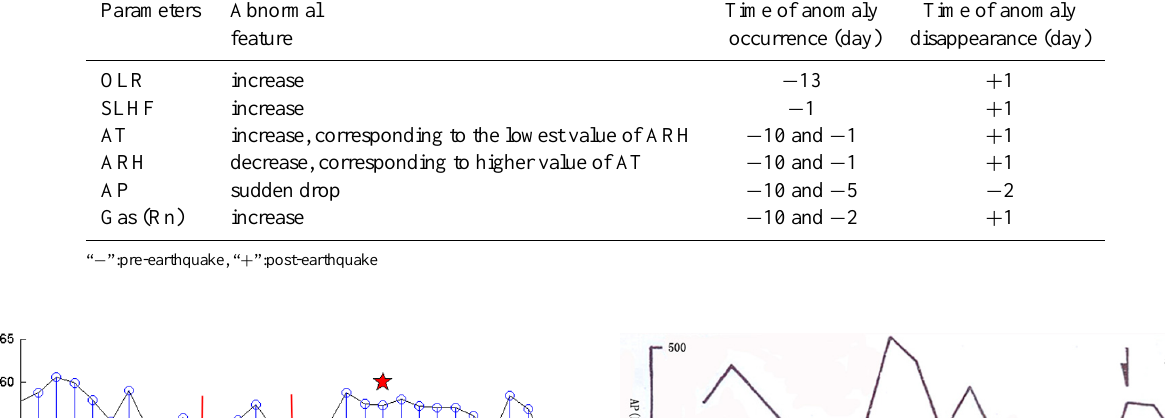
Table 1. The variation characteristics of earth-atmosphere system multi-parameters before and after the Wenchuan earthquake. Parameters Abnormal